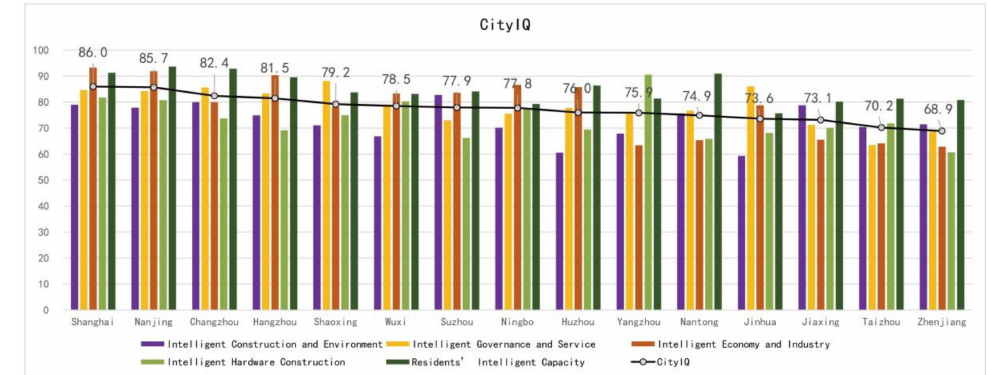
Figure 5. Overall CityIQ scores of the fifteen major cities in the Yangtze River Delta region, China.